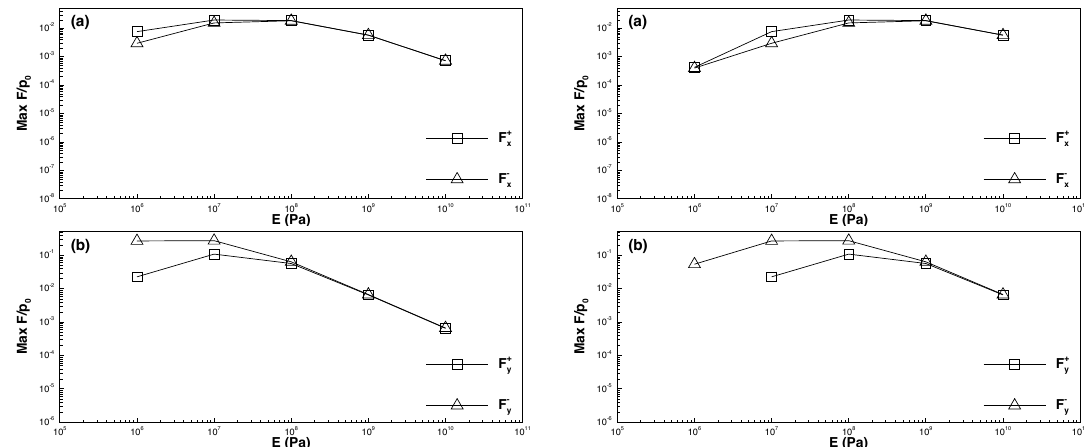
Figure 16. Maximum force on the pipeline in relation to Young’s modulus; left : k = 1.0 × 10 − 3 m/s; right : k = 1.0 × 10 − 4 m/s. ( a ) Horizontal component; ( b ) vertical